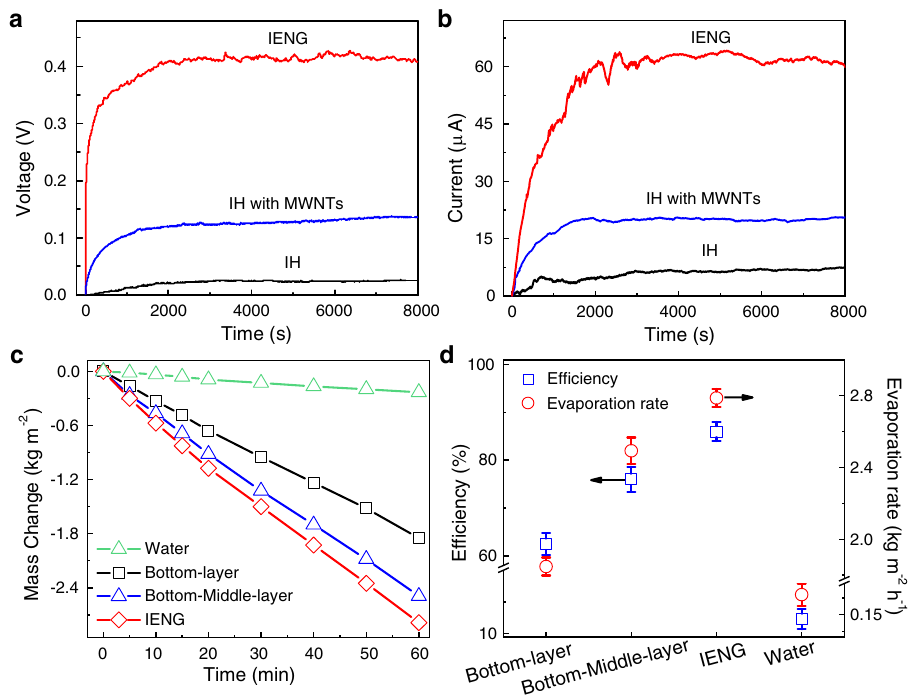
Fig. 2 | Power generation performance and evaporation characteristics of the IENG. a Open-circuit voltage per unit area of the IH, the IH with MWNTs and the IENG. b Short-circuit currents per unit area for the IH, the IH with MWNTs and the IENG. c Waterevaporation rates of bulk waterand the IENG with different layersin